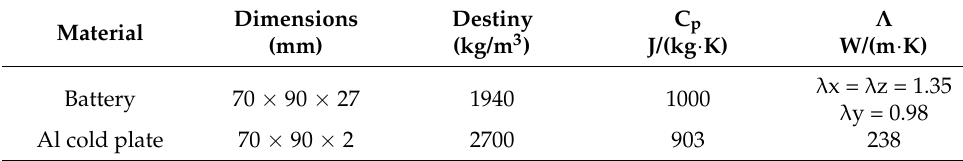
Table 1. Material parameters of the battery and Al cold plate.